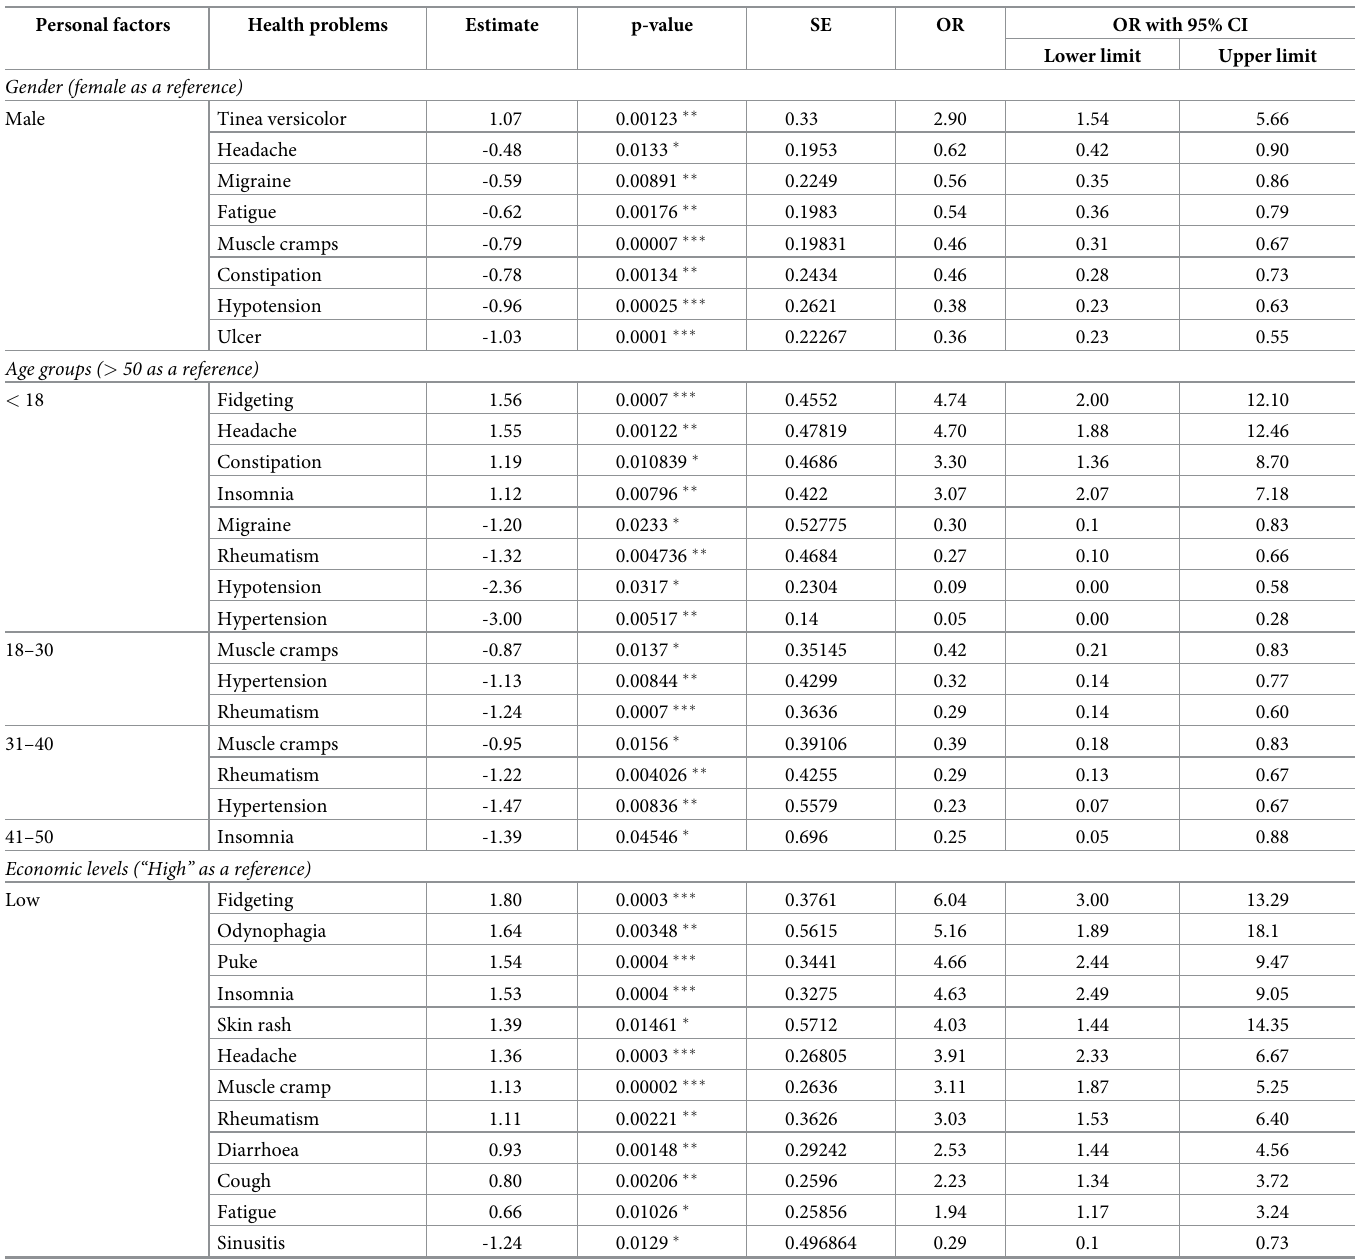
Table 3. Logistic regression and odd ratio relating personal factors to health